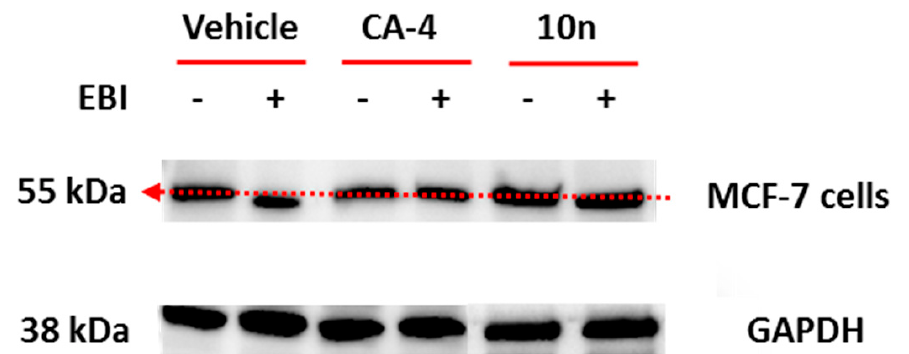
Figure 9. Effects of compound 10n on the inhibition of the bisthioalkylation of Cys239 and Cys354 of